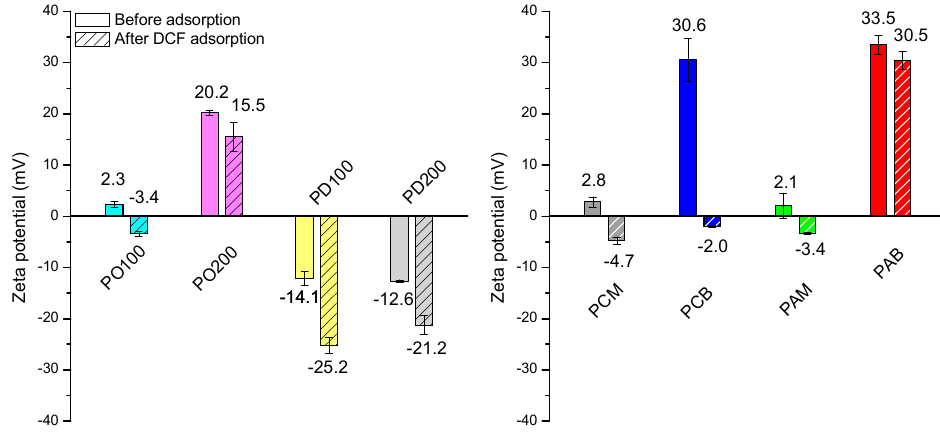
Figure 6. Zeta potential measured for P composites before and after adsorption of DCF. Measured values were compared with the zeta potential of the composites before drug adsorption previously reported in Smiljanic et al. (2020) [29]. Data were used with permission from Microporous and Mesoporous Materials, Elsevier, license number: